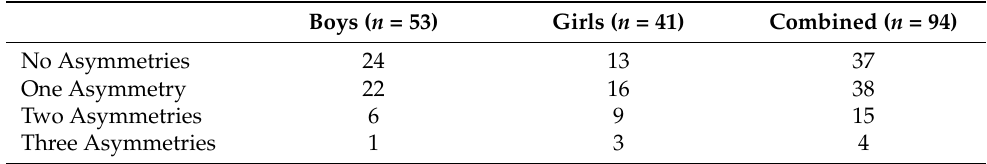
Table 3. Prevalence of asymmetries in boys and